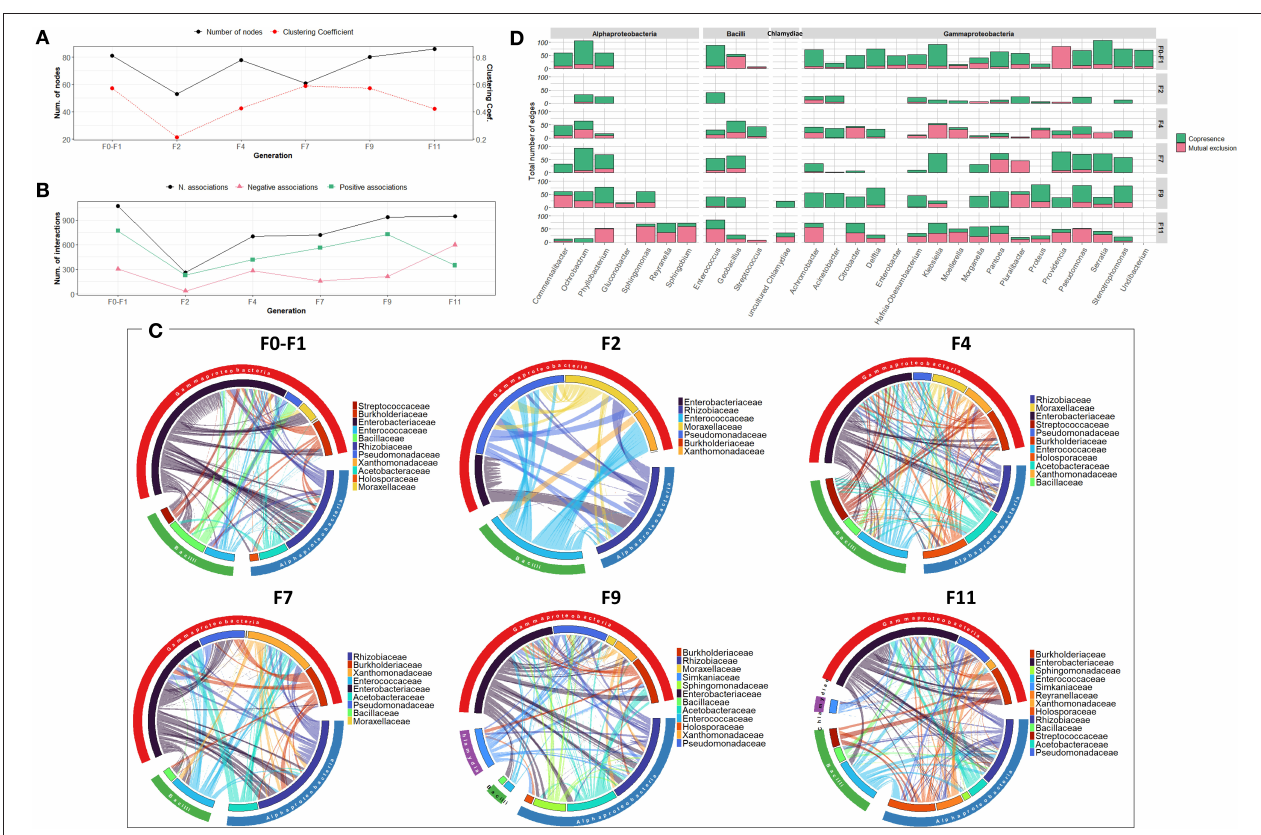
FIGURE 3 | Bacterial community network within the guts of C. capitata teneral during laboratory adaptation of Vienna 8 FD-GSS strain. (A) Total number of nodes and clustering coefficient. (B) Total number of negative (red) and positive (green) associations. (C) Chord diagram displaying direct relationship between OTUs at family level. The size of the ribbon is proportional to the weight of the association between the OTUs assigned to the respective segments and the color of the ribbon present in the direction of the interaction. (D) Number of positive and negative associations at genus level.